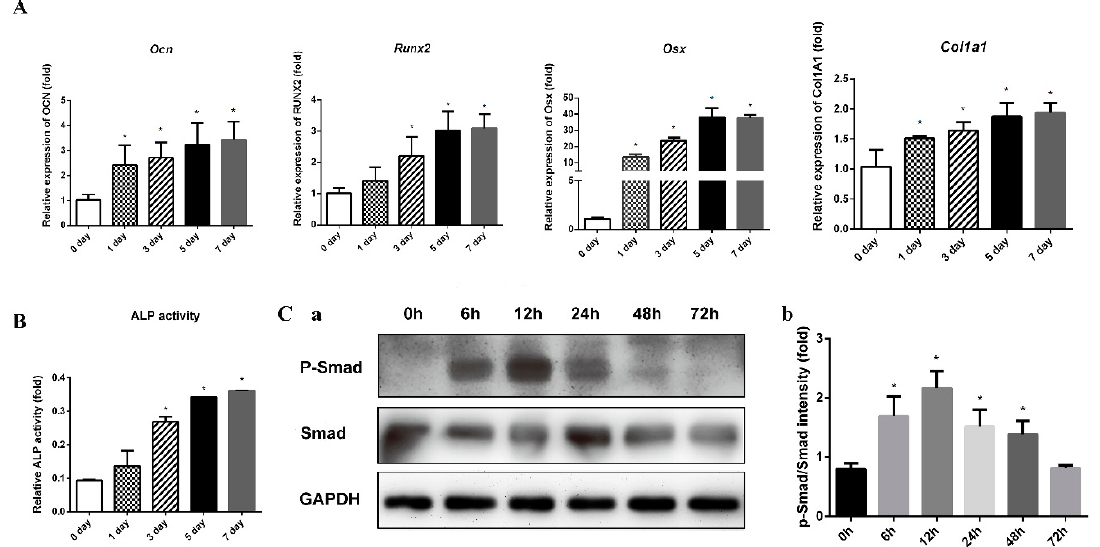
Figure 2. BMP2 induced osteoblastic differentiation of the C2C12 cells. Ocn , Runx2 , Osx and Col1a1 mRNA levels ( A ) and the ALP activity ( B ) at 0, 1, 3, 5 and 7 days of osteogenic induction. ( C-a ) The protein levels of phosphorylated Smad1 / 5 / 9 and total Smad1 were evaluated by Western blotting at 0, 6, 12, 24, 48 and 72 h after the addition of BMP2. ( C-b ) Relative density of the protein expression levels. All data are presented as the mean ± SD ( n = 3). * p < 0.05.